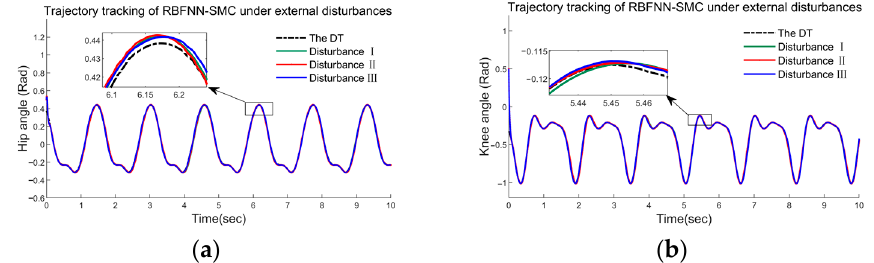
Figure 18. The tracking response of RBFNN-SMC of the joints under Case Ⅲ . ( a ) the response of 𝜃 (cid:2869) and ( b ) the response of 𝜃 (cid:2870) under the disturbances with different magnitudes.